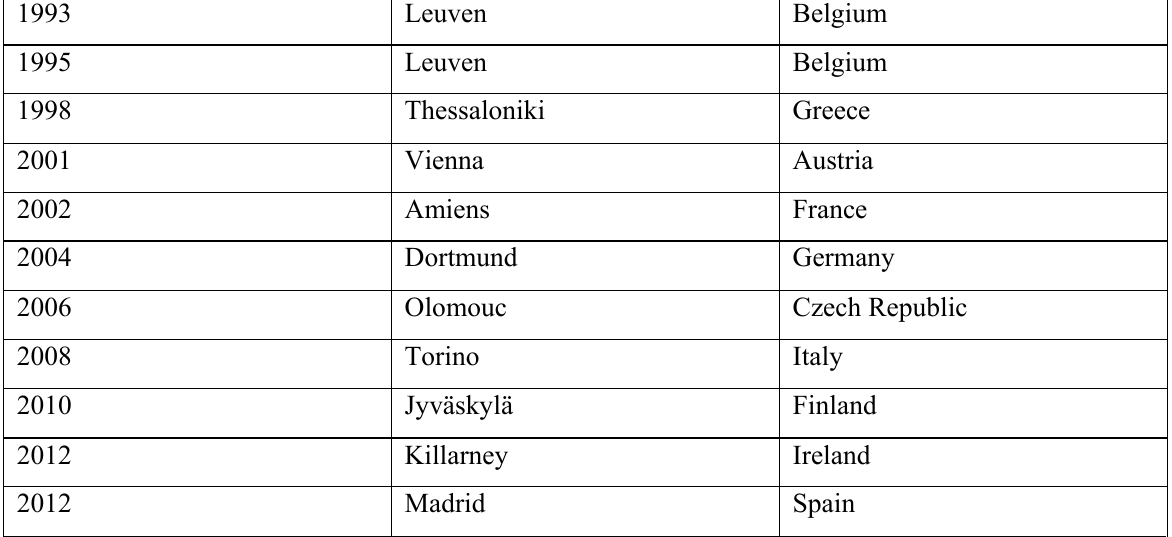
Table 1 Host cities of European Congresses of Adapted Physical Activity